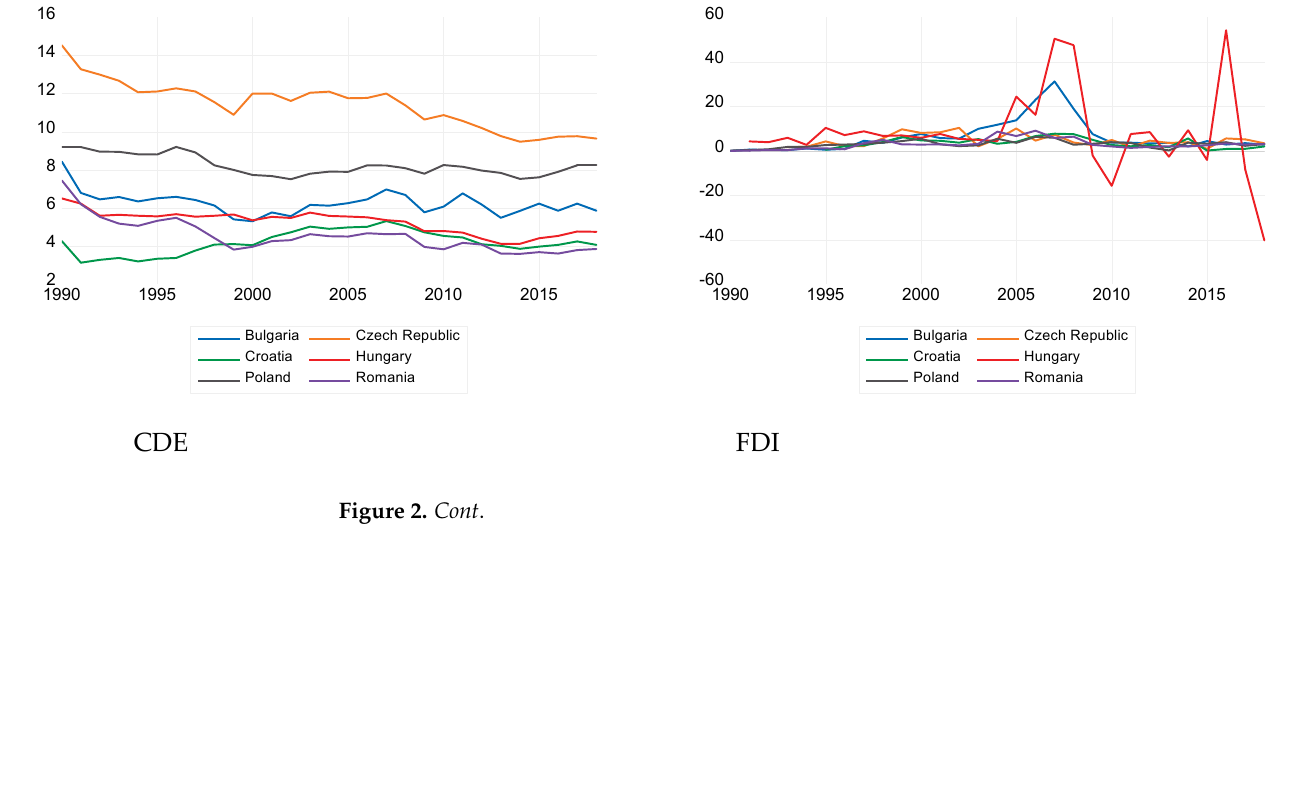
TO Figure 2. Trends regarding the variables reflecting renewable energy transition for the period 1990– 2018. Source: Authors’ projection, using Eview. 4. Empirical Results In time series data, before beginning the analysis of cointegration and causality, the most important requirement is to check the stationarity [109]. In order to test the station- arity, we used Levin, ADT, and PP panel unit root tests for the full sample, the results being presented in Table 3. For four variables (GDP, RE, HDI, and TO), the null hypothesis of a unit root cannot be rejected, being nonstationary and integrated of order one. When